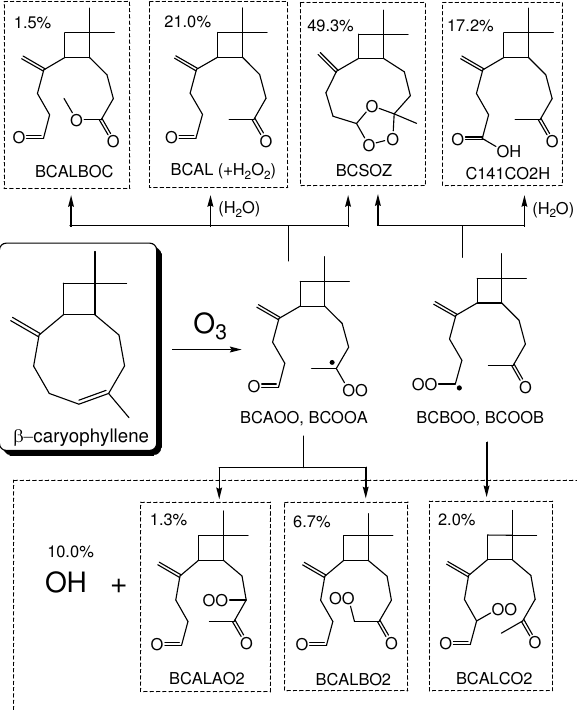
Fig. 1. Simplified schematic of the first-generation product distri- bution from the ozonolysis of β -caryophyllene, as represented in Figure 1. Simplified schematic of the first-generation product distribution from the ozonolysis 3 MCM v3.2. The displayed (molar) product yields correspond to of E(cid:16) caryophyllene, as represented in MCM v3.2. The displayed (molar) product yields 4 ozonolysis at 298 K in 760 Torr air at 50% relative humidity; with correspond to ozonolysis at 298 K in 760 Torr air at 50 % relative humidity; with cyclohexane 5 cyclohexane present to scavenge all OH radicals. The further chem- present to scavenge all OH radicals. The further chemistry of BCALAO2, BCALBO2 and 6 istry of BCALAO2, BCALBO2 and BCALCO2 is shown in Fig. 3. BCALCO2 is shown in Fig. 3. The figure omits to represent additional minor ozonolysis 7 The figure omits to represent additional minor ozonolysis channels channels accounting for 1% of the chemistry, which are fully represented in MCM v3.2. 8 accounting for 1% of the chemistry, which are fully represented in MCM